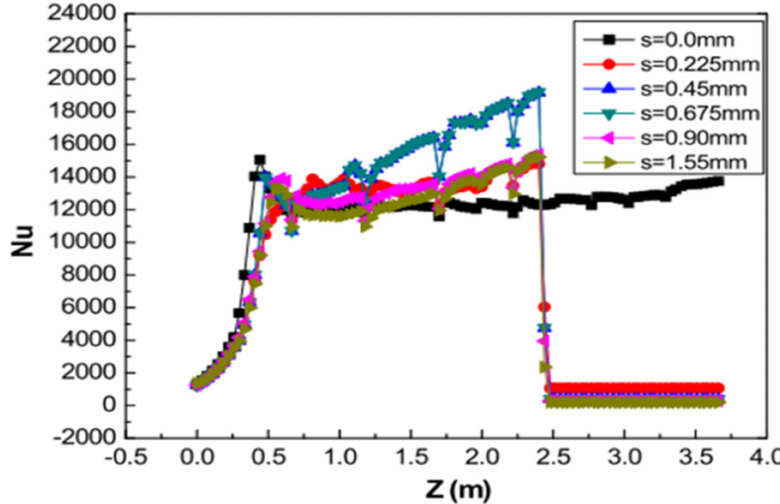
Figure 7. Nusselt number along a tube for varying fouling layer thickness